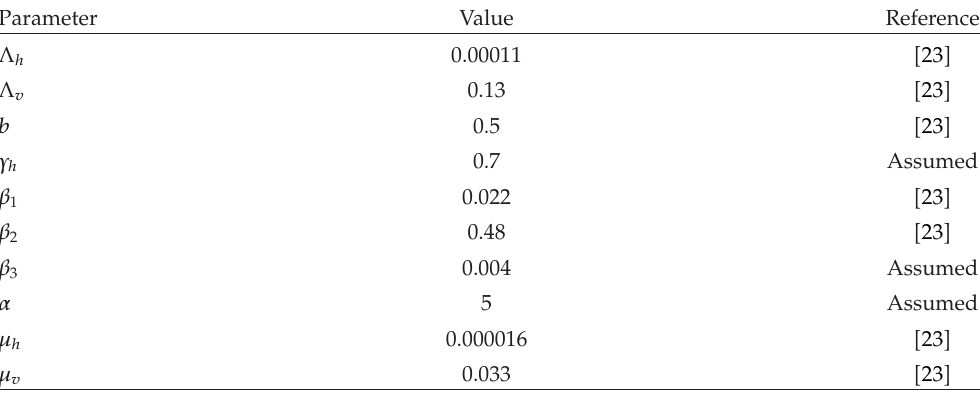
Table 1: Values for parameters used for sensitivity analysis.